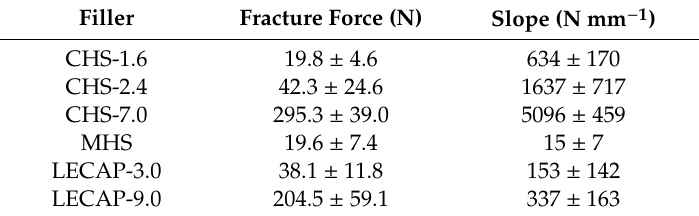
Table 4. Mechanical properties of individual filler particles.